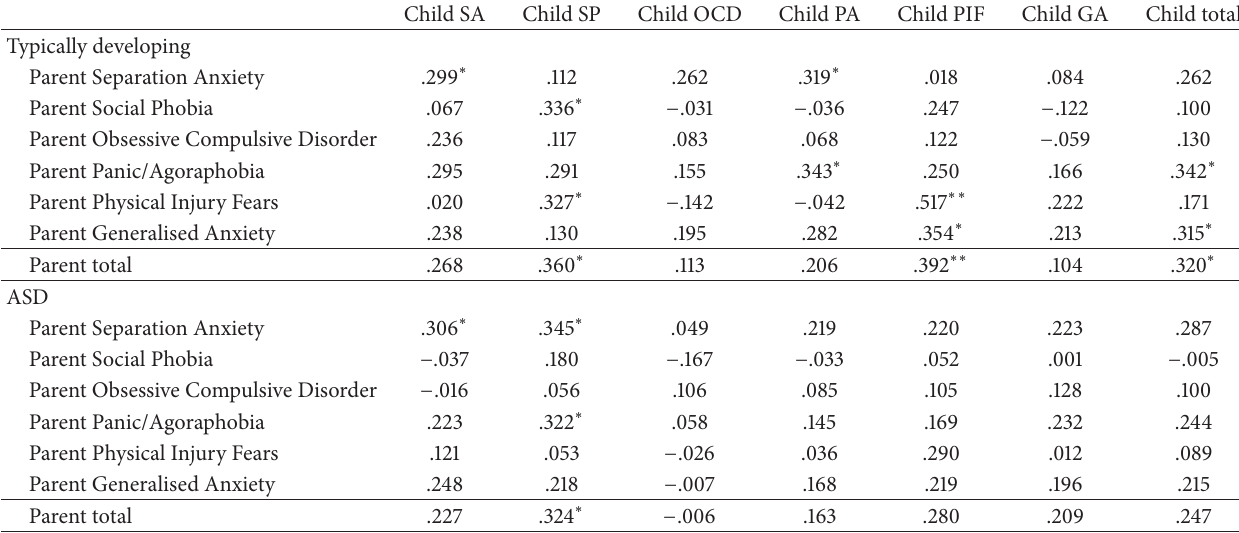
Table 2: Agreement between parent and child SCAS subscales and total score for the ASD and TYP